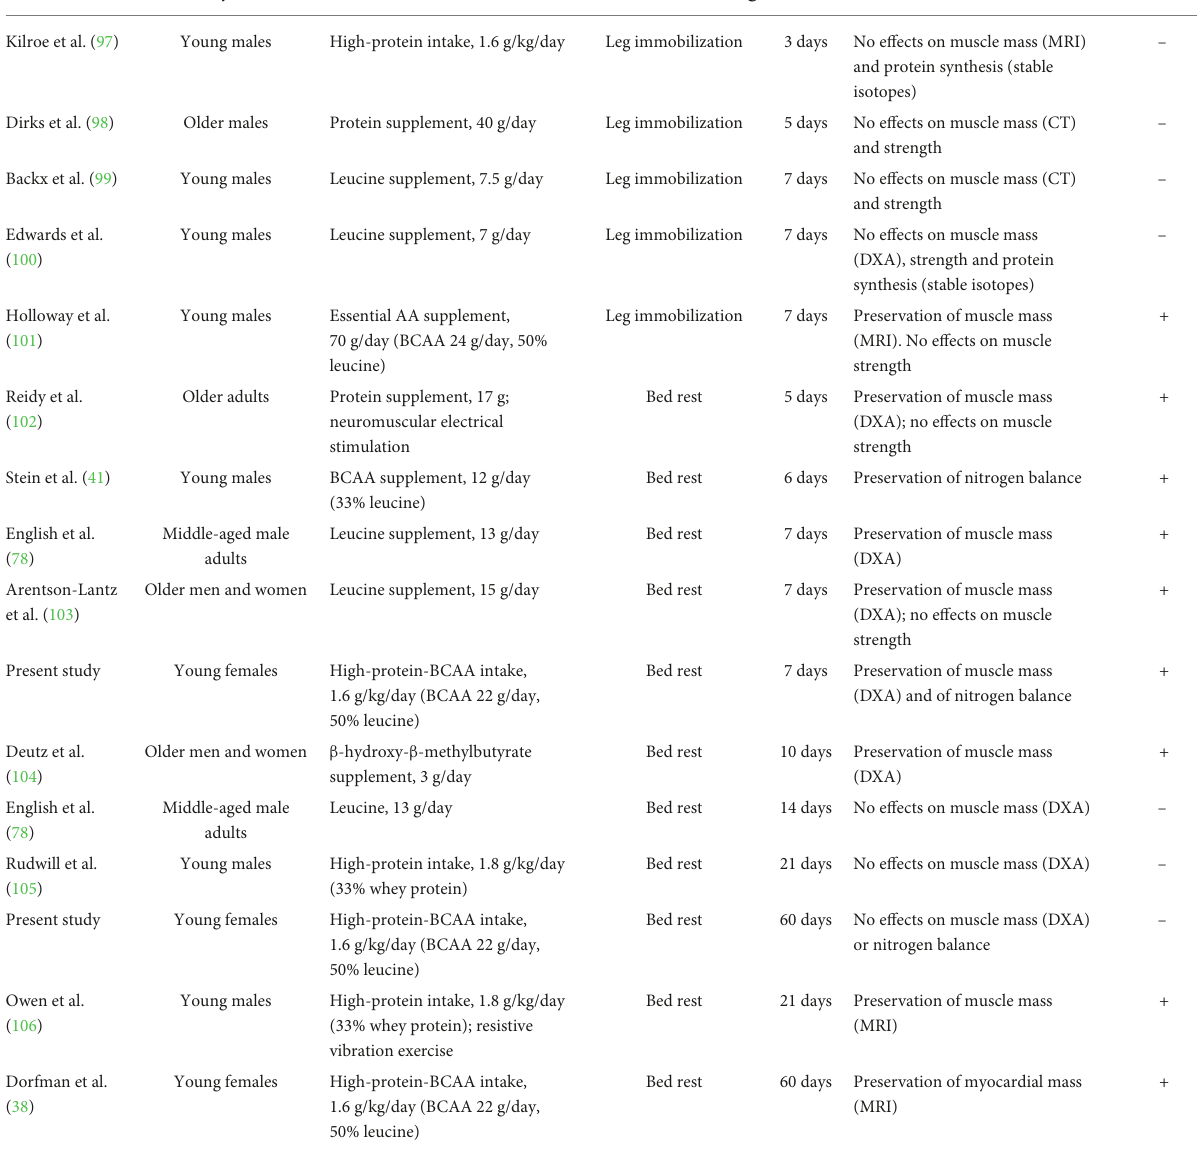
TABLE 4 Effects of amino acid and protein supplements on muscle mass and function in different models of muscle unloading in healthy volunteers of different ages and